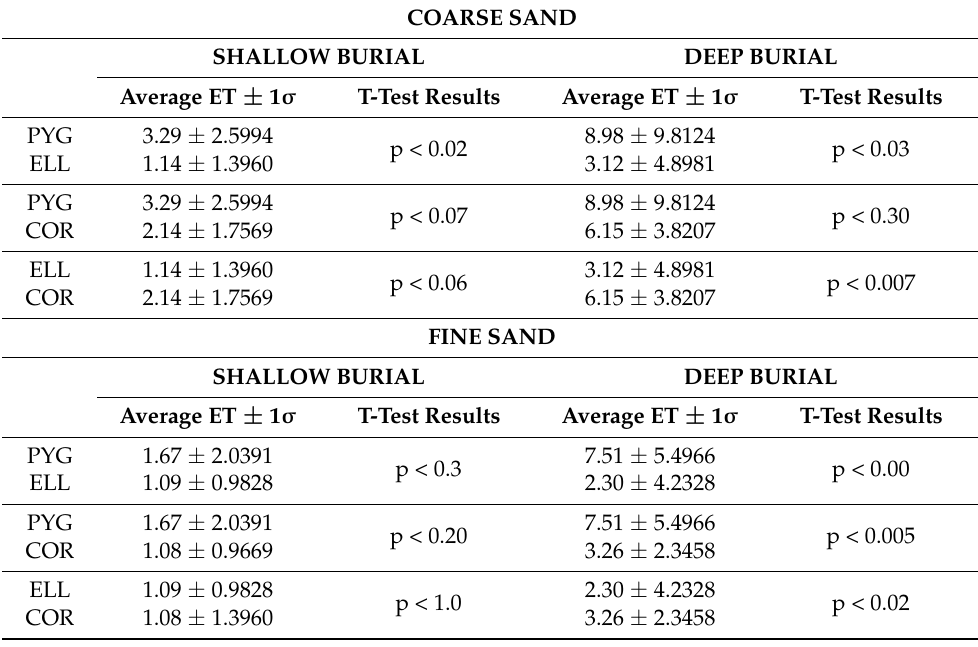
Table 8. Average Escape Time defined as in Table 7. Data shown here compare performance of the three test species to one another at different burial depths and in different sediments. Shallow Burial—results for escape tests conducted from 1 to 5 cm burial depth. Deep Burial—results for escape tests conducted from 6 to 10 cm burial depth. Top half of the table compares the species burrowing in coarse sand. Bottom half of the table compares the species burrowing in fine sand. ET—escape time in